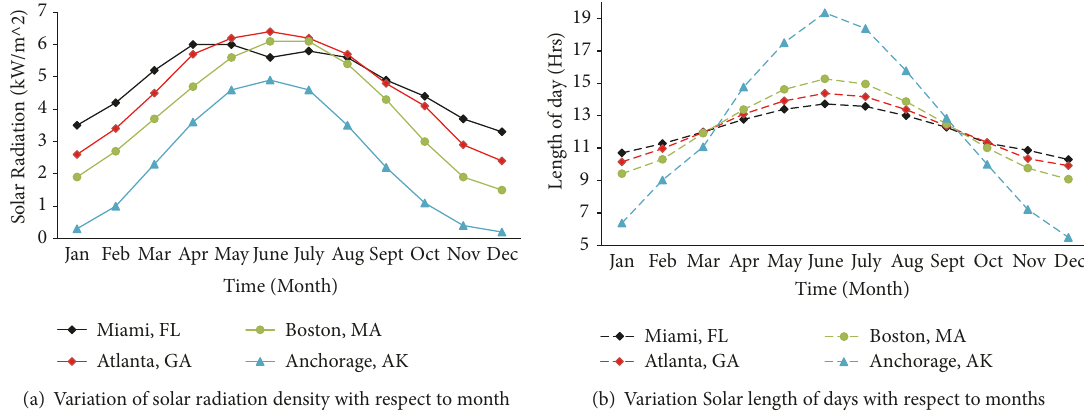
Figure 1: Comparison of solar radiation and length in terms of month on horizontal surface by region.